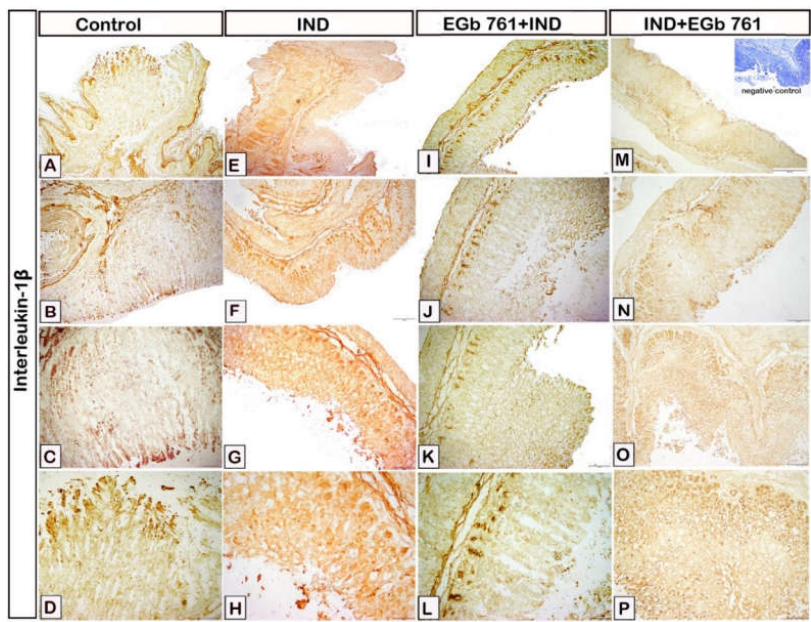
Figure 6. Photomicrograph immunohistochemistry of gastric mucosal samples shows the effects of indomethacin and EGb761 on gastric IL-1 β expression. ( A – D ): Control mice. ( E – H ): Indomethacin- induced ulcer (IND). ( I – L ): EGb 761 +IND (Prophylactic EGb 761). ( M – P ): IND+EGb 761 (Therapeutic EGb 761). Negative marker control is shown in the inset of Figure 6M. IND: Indomethacin; EGb 761: Standardized G. biloba extract; IL-1 β : Interleukin-1 β .